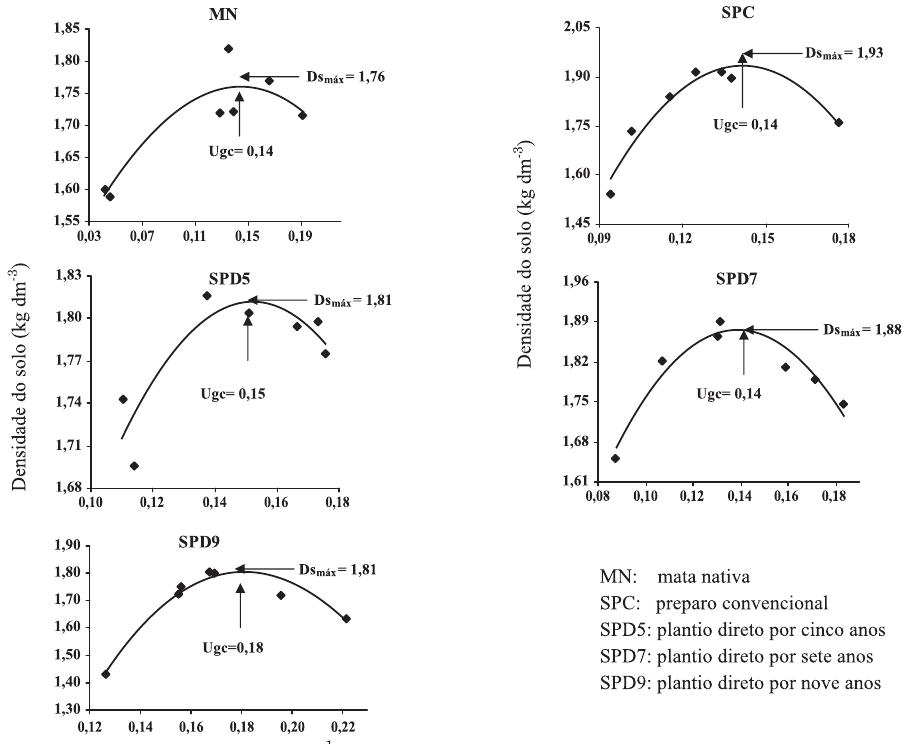
Figura 4. curvas de compactação de um Latossolo vermelho determinada pelo ensaio de proctor na camada de 0,20–0,30